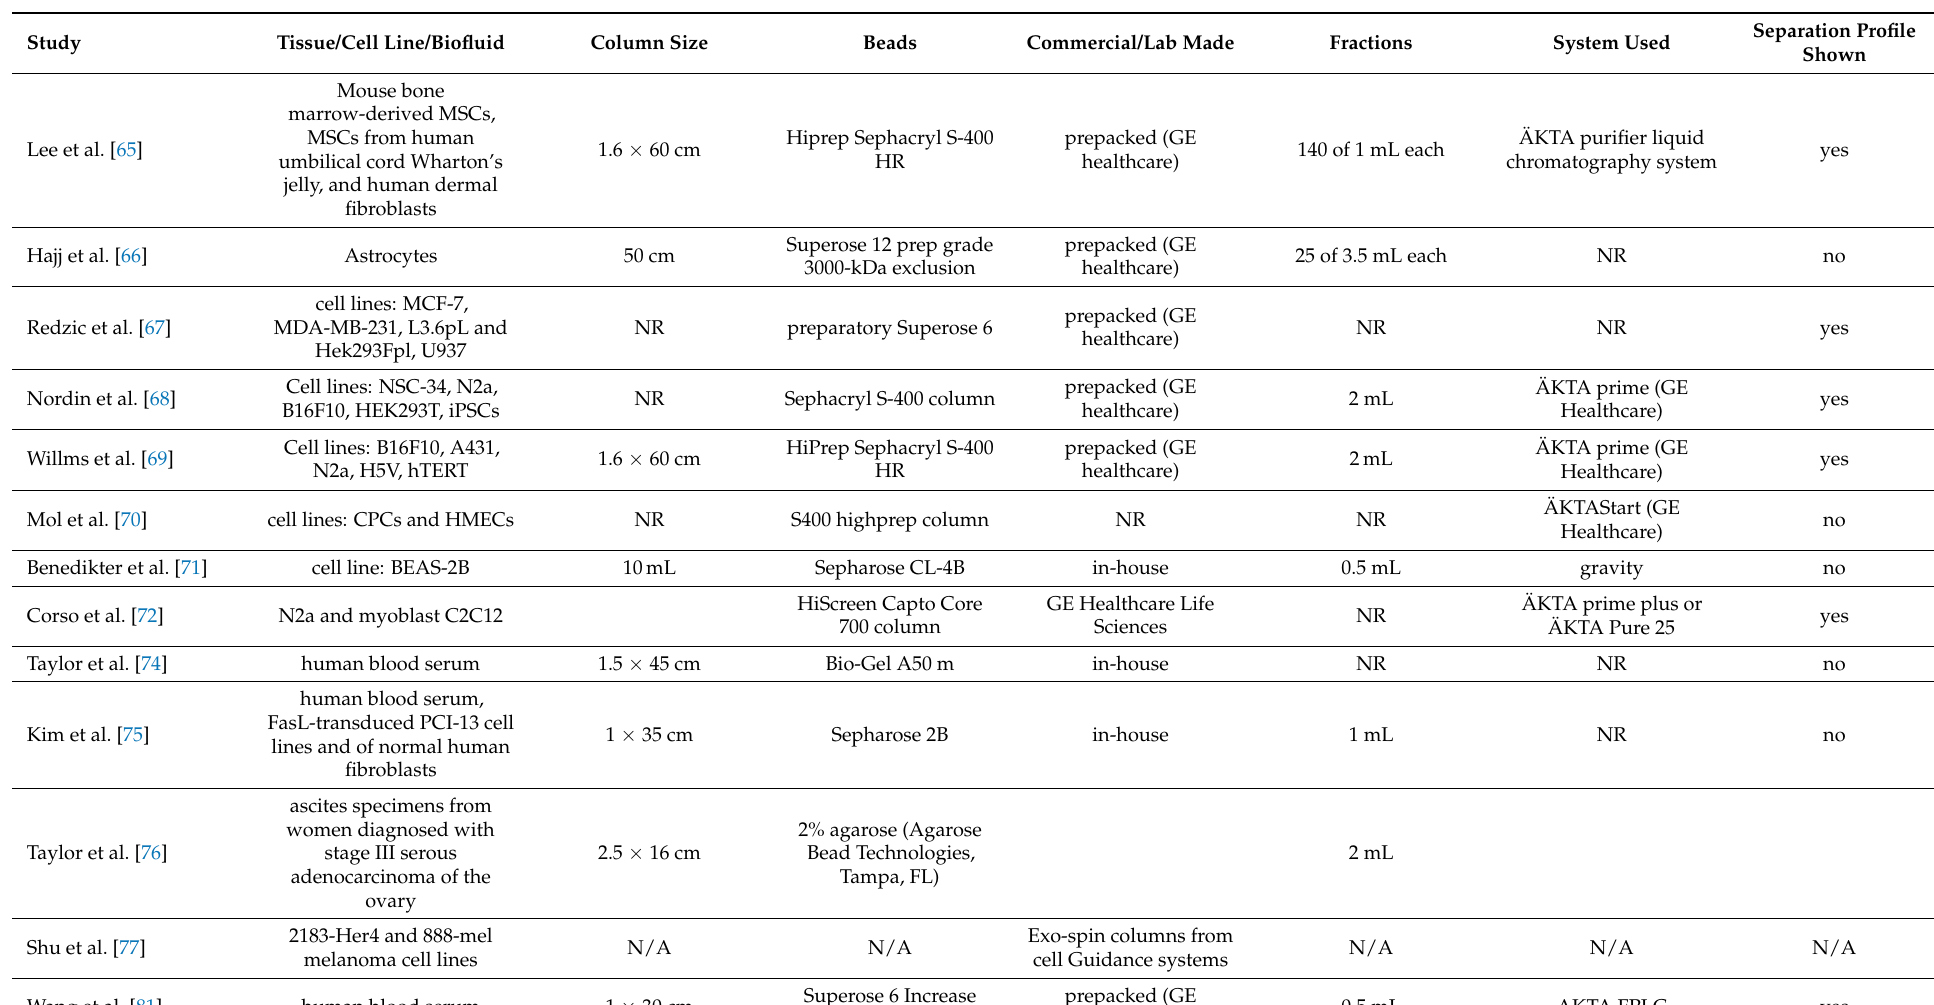
Table 2. A non-exhaustive list of studies that used SEC for EV